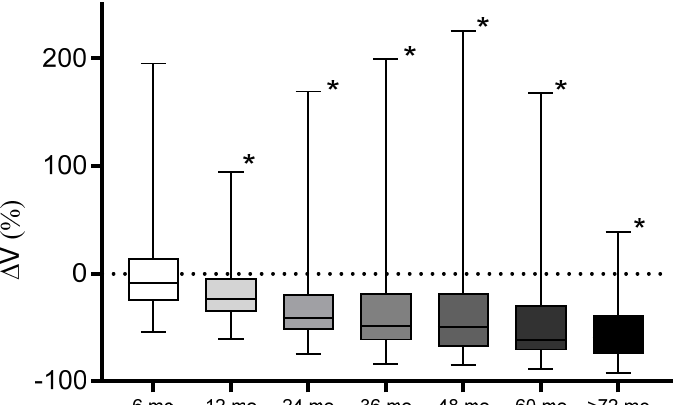
Figure 2. Mean tumor volume during the follow-up period. Twelve months after SRS, the mean tumor volume of the collective was significantly decreased (marked with *) compared to the baseline (6 months: p = 0.91, 12 months: p < 0.0001, 24 months: p < 0.0001, 36 months: p = 0.018, 48 months: p = 0.021, 60 months: p < 0.0001, >72 months: p < 0.0001).